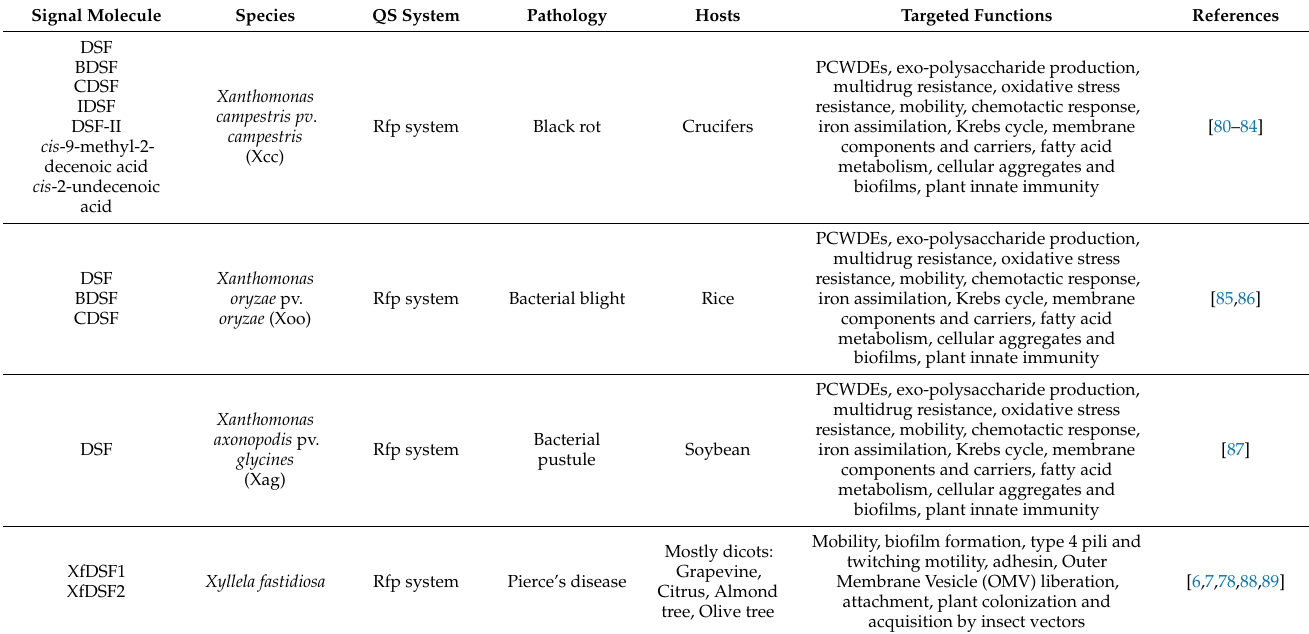
Figure 3. General structure of the Diffusible Signal Factor (DSF). Signal molecules are cis- 2-unsaturated fatty acids . Fatty acid carbon chains vary in their lengths, double-bond configurations, and side-chain modifications, particularly methylation. Fatty acid carbon chains range from 8 to 14 carbons . A given species is able to produce different molecules. Methylation occurs at the first carbon for R. solanacearum signal molecules 3-OH-PAME or 3-OH-MAME. Table 3. Overview of DSF-mediated quorum-sensing processes in phytopathogenic bacteria.